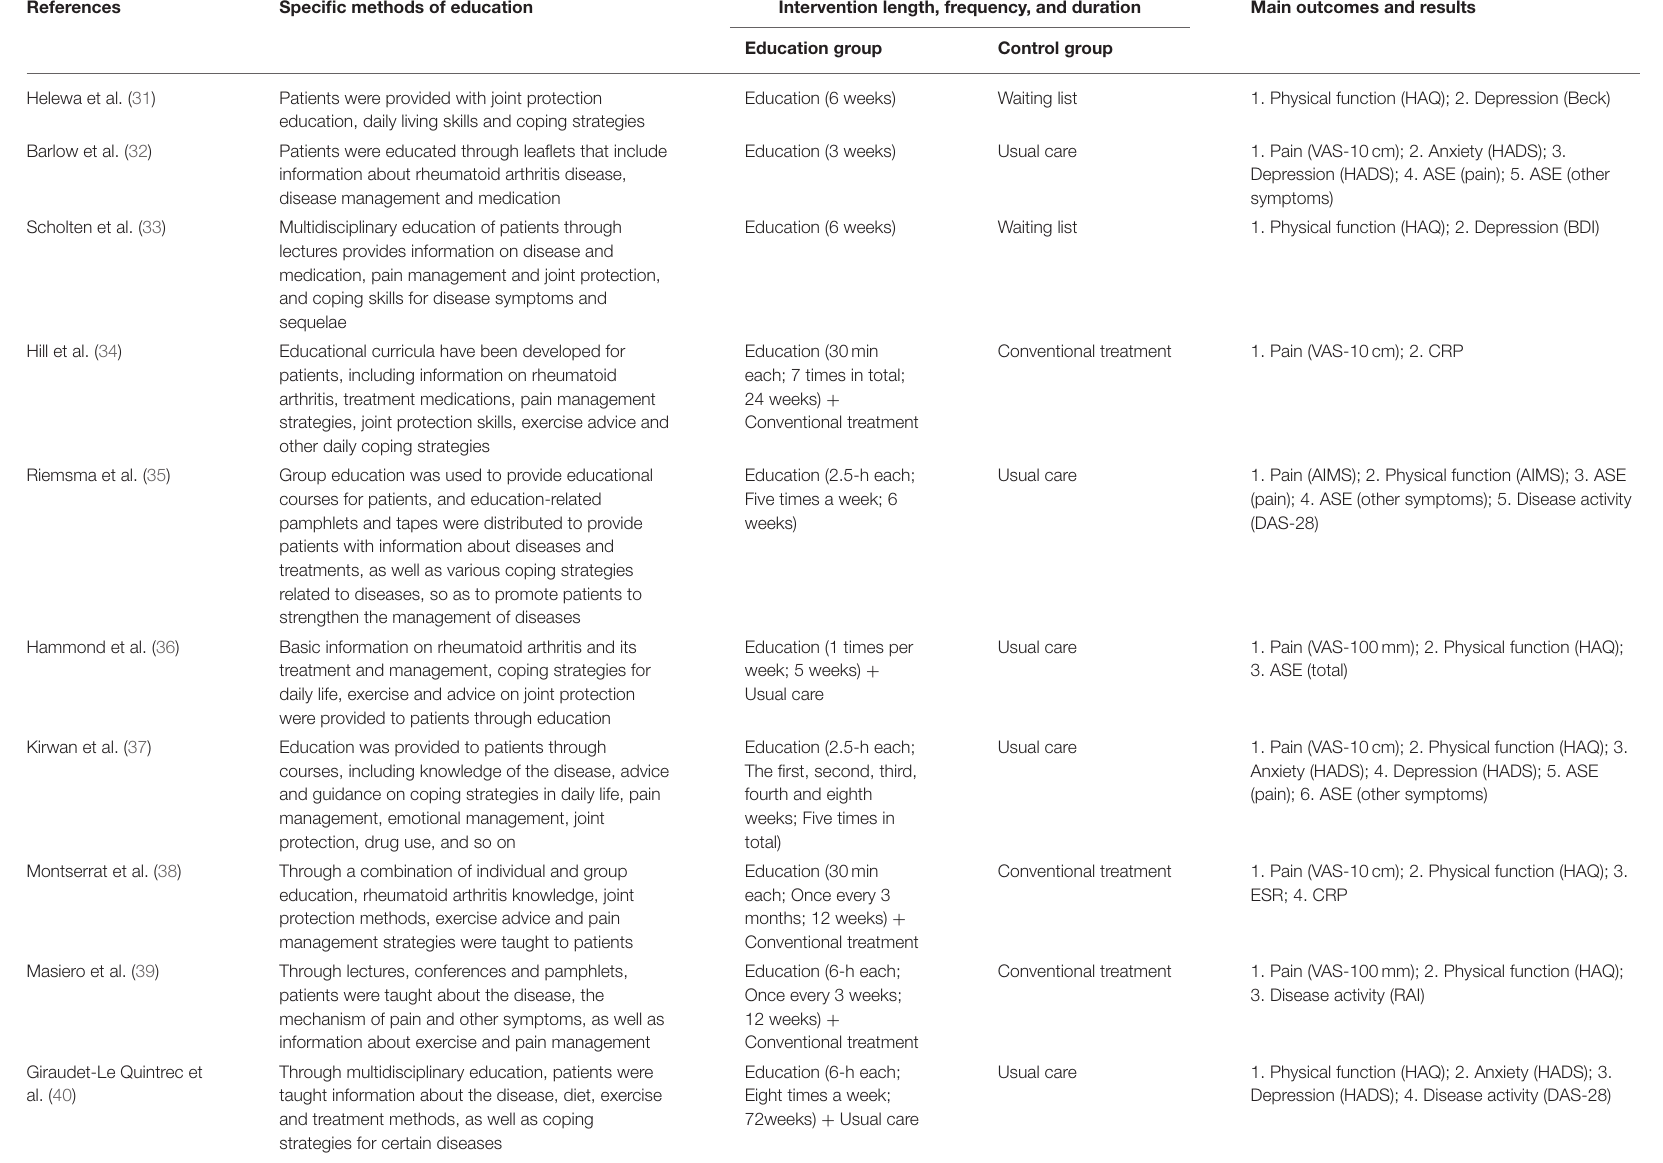
TABLE 2 | Intervention, main measures, and